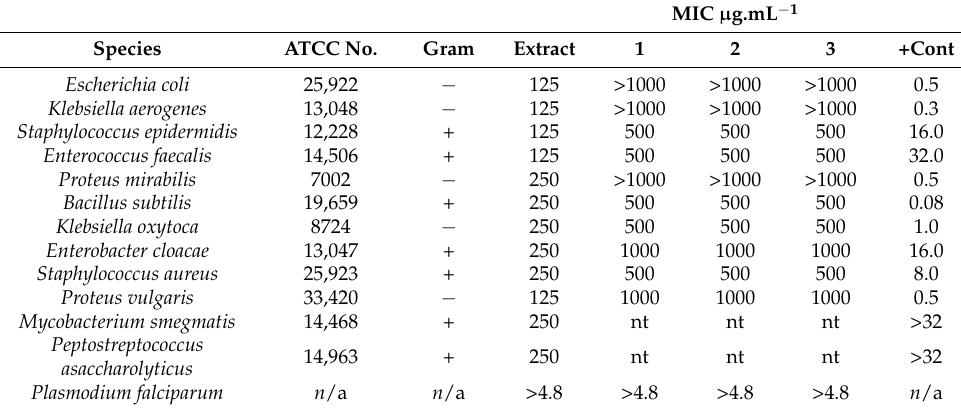
Table 2. Bacterial and protozoan species, strain and MIC value of the crude methanol extract of Vitex doniana stem bark: all values are in µ g.mL − 1 , +Cont is tetracycline. MIC µ g.mL − 1 Species ATCC No. Gram Extract 1 2